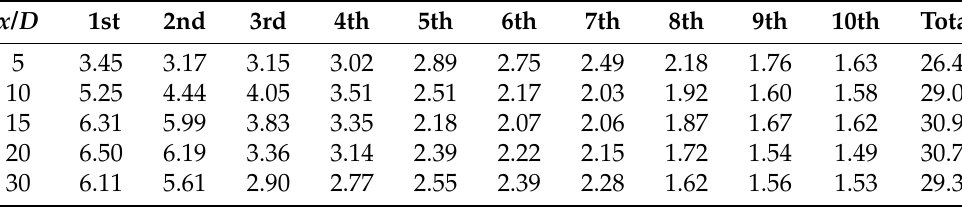
Table 1. Relative and cumulative turbulent energy content in the POD eigenmodes